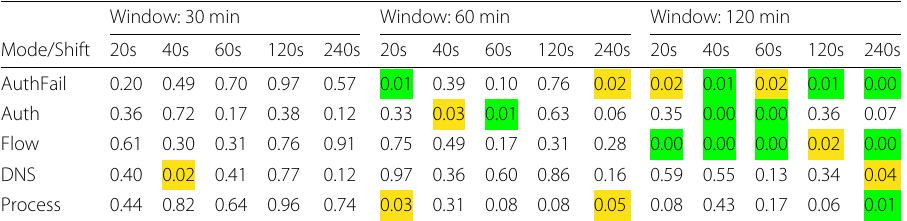
The p -values are rounded to two decimal places, with rounded values at most 0.01 highlighted in green and values between 0.02 and 0.05 highlighted in